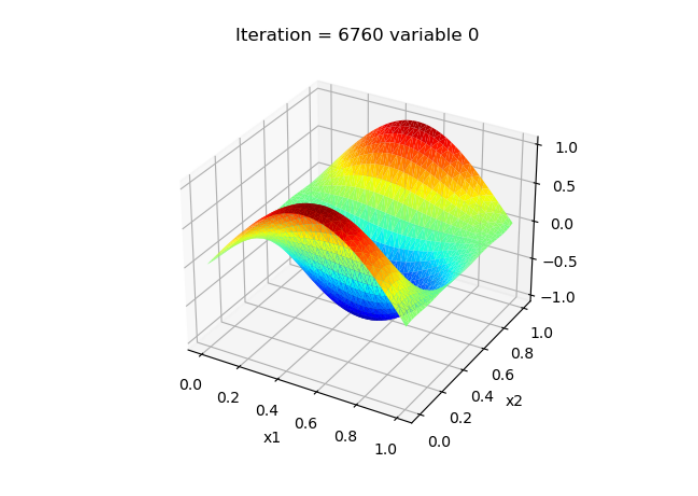
Figure A3. Solution to wave Equation